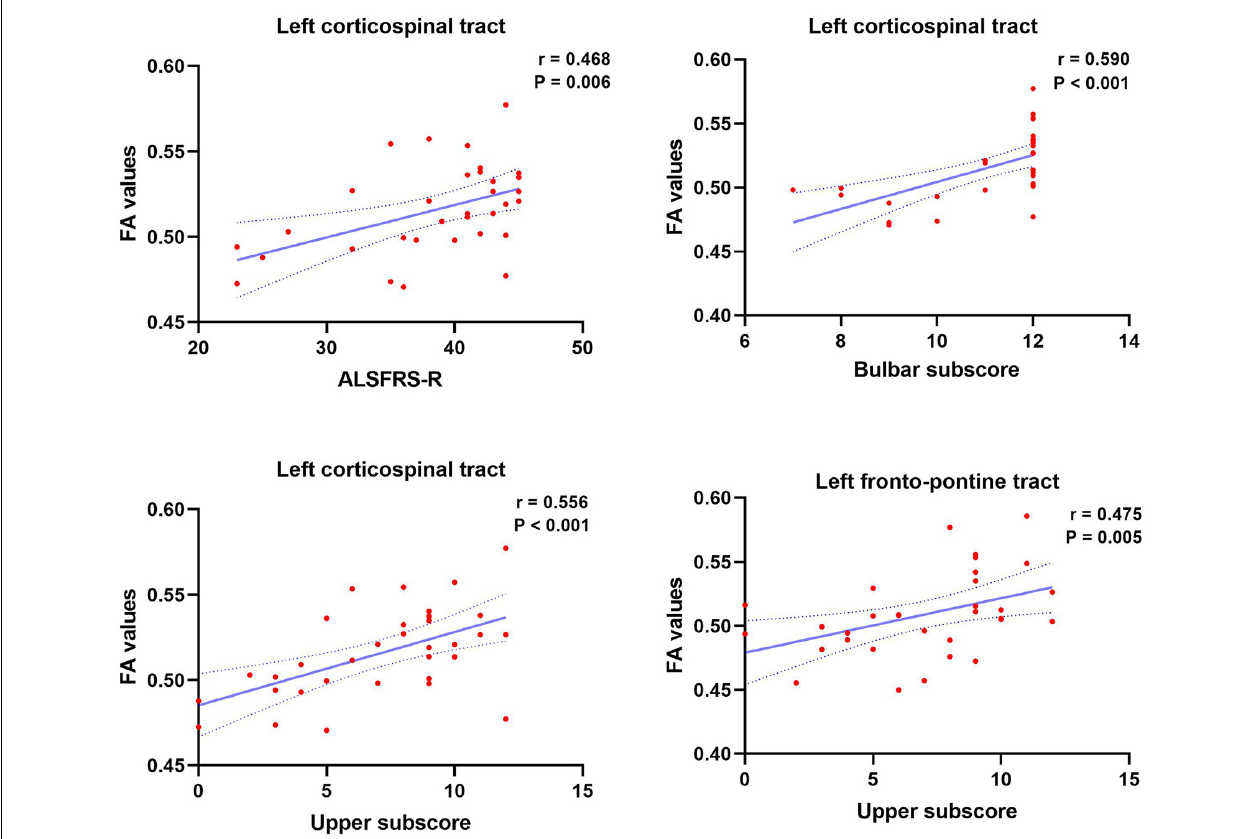
FIGURE 4 | Significant clinical correlates of ALSFRS-R, ALSFRS-R bulbar subscore, and upper limb subscore, with FA values of brainstem pathways in patients with ALS. Dotted lines represent the 95% confidence region of the linear model fit. P < 0.008 (0.05/6) was considered statistically significant after Bonferroni correction. ALSFRS-R, Revised Amyotrophic Lateral Sclerosis Functional Rating